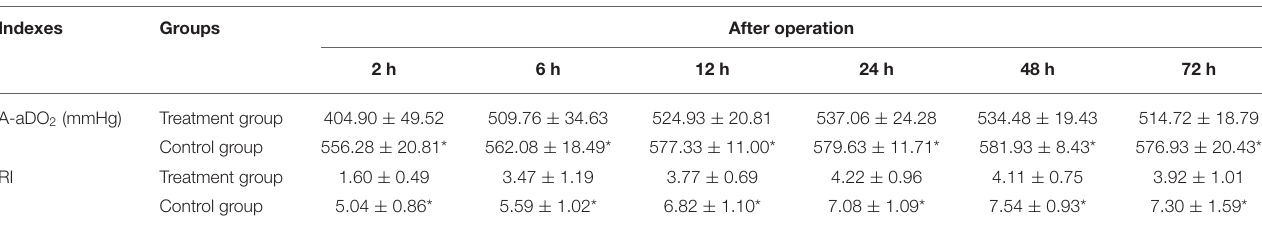
TABLE 4 | Test results of pulmonary function indexes of children in both groups ( x ± s, n = 15).